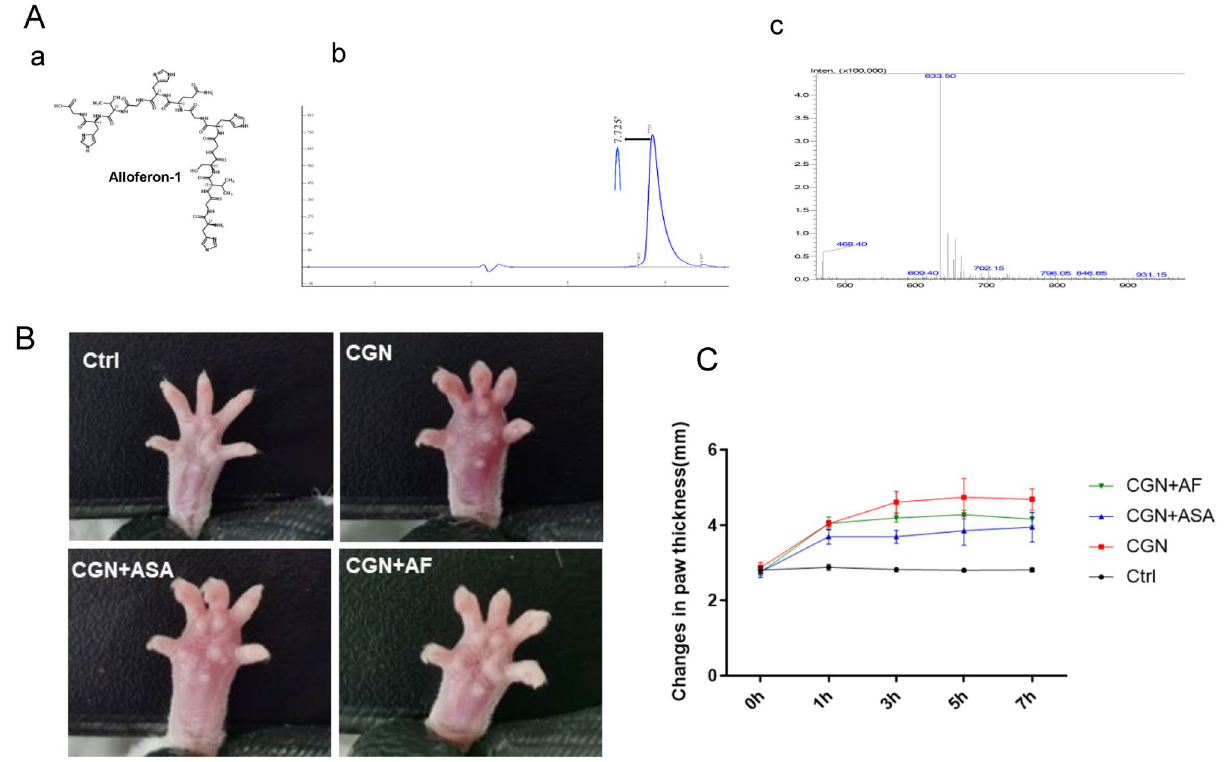
Figure 1. The effect of alloferon-1 on the paw edema in carrageenan-induced mice. Mice were pretreated by intravenous injection with alloferon-1 (22 mg/kg body weight) for 6 h or aspirin (250 mg/kg body weight) for 2 h before subplantar injection of λ-carrageenan. Ctrl: saline solution; CGN: λ-carrageenan; AF: alloferon-1; ASA: aspirin. ( A ) a, Structure of alloferon-1; b, High pressure liquid chromatography (HPLC) detection